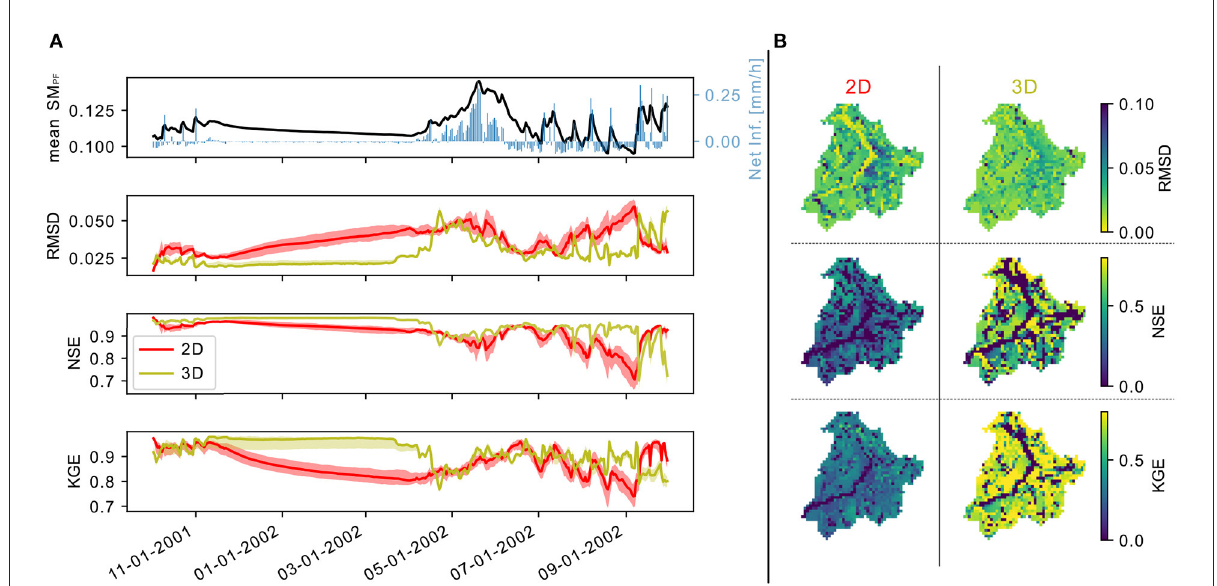
FIGURE5 In (A) the timeseries of ParFlow-CLM (PF) domain average in time for water year 2002 (mean SM PF ) and the simulated net infiltration (qflx_infl-qflx_tran_veg ParFlow-CLM variables). Below the timeseries of Root Mean Square Difference, Nash-Sutcliff Efficiency, and Kling-Gupta Efficiency comparing the PF mean to that of the 2D Convolutional Neural Network (CNN) ( 2D ) or the 3D CNN ( 3D ). The semi-transparent bands represent the 0.2–0.8 interquantile ranges among repetition of the same ML configuration (i.e., different initialization). In (B) the temporal statistics comparing the timeseries at each pixel of PF and the 2D and 3D CNNs.